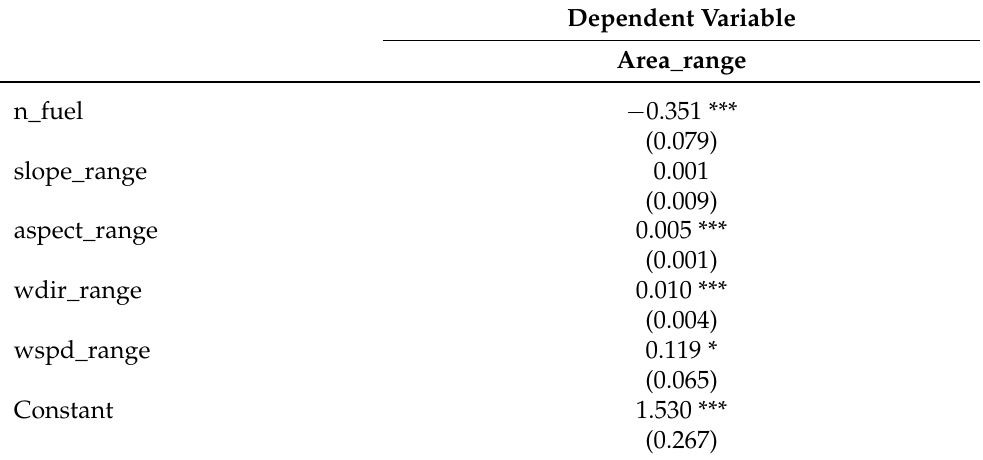
Table 2. Generalized Linear Model Summary for Modeling the Range of Forecast Burn Area Val- ues (area_range) from the Range of Fuel Models (n_fuel), Terrain Slope (slope_range), Aspect (as- pect_range), 10 m Height Wind Direction (wdir_range), and 10 m Height Wind Speed (wspd_range). Each variable is shown with its respective regression coefficient, statistical significance (asterisks), and root mean squared error (RMSE, in parentheses).